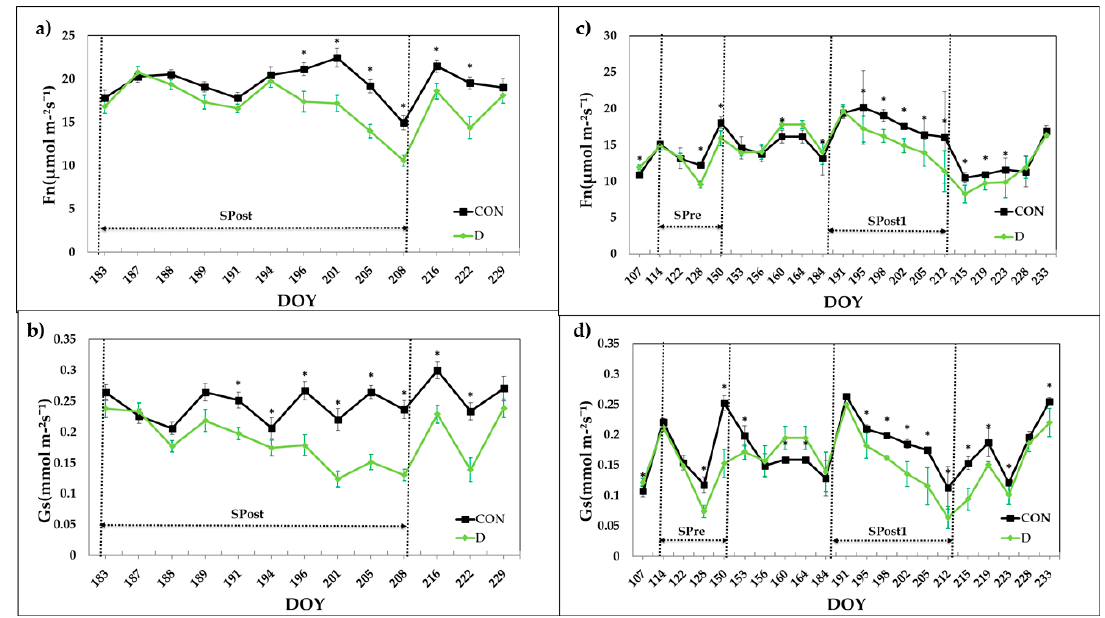
Figure 3. Seasonal pattern of: ( a ) net photosynthetic rate (Fn); ( b ) stomatal conductance (Gs) in 2015; ( c ) net photosynthetic rate (Fn) and ( d ) stomatal conductance (Gs) in 2017. Each value is the mean of 32 measurements ± standard error. An asterisk (*) indicates statistically significant differences between treatments at p < 0.05. The vertical black dashed line marks the start and end of the drying period. DOY is day of the year.